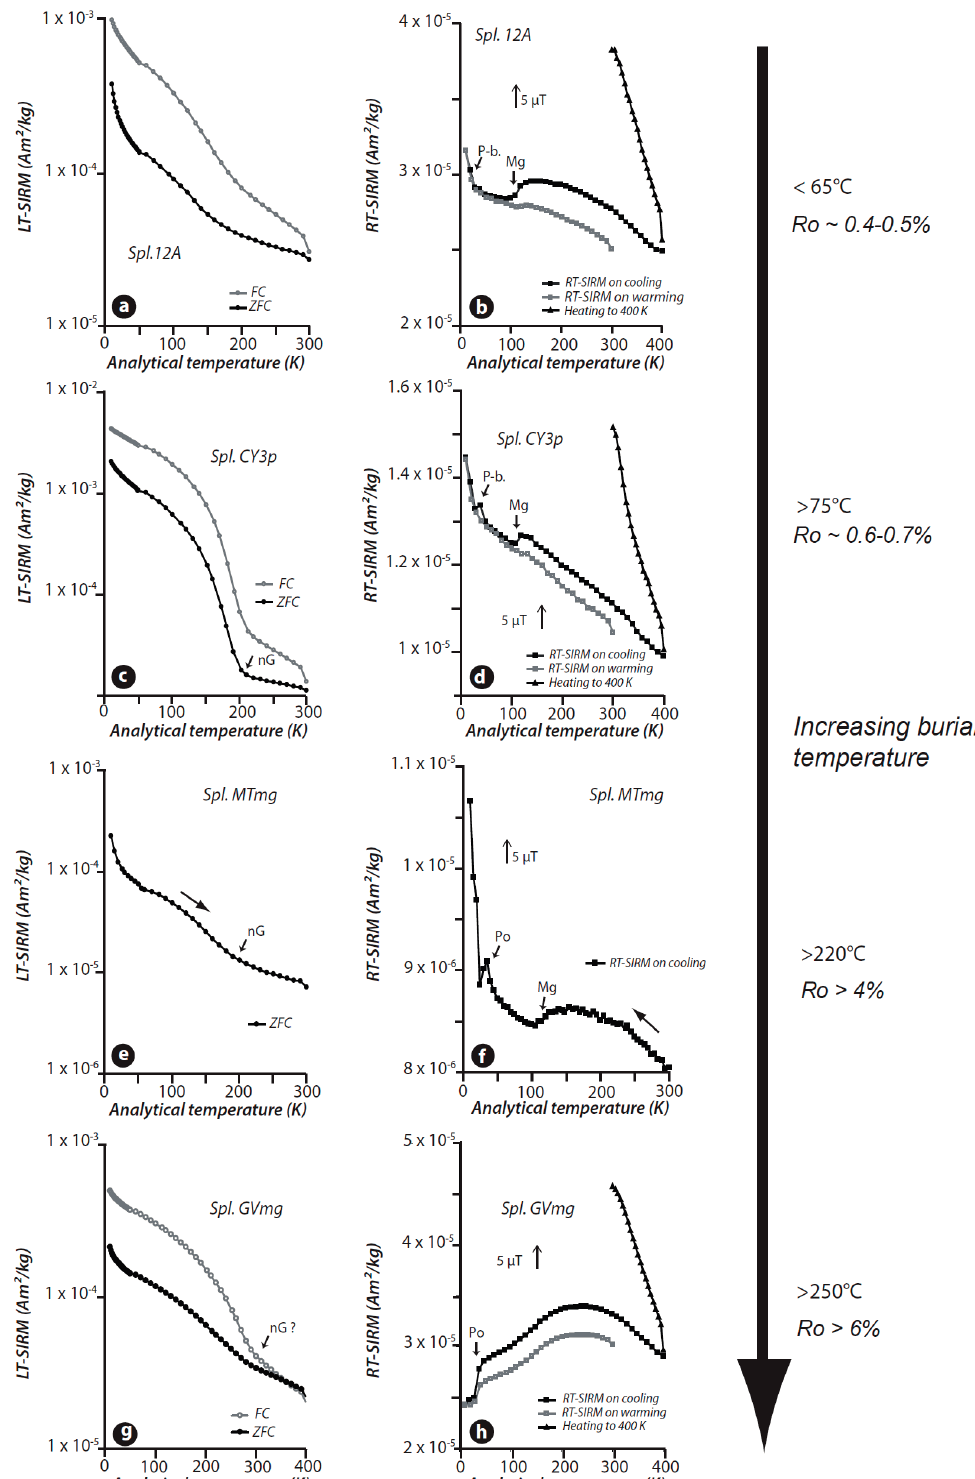
Figure 5. Evolution of the saturation isothermal remanent magnetization for four characteristic samples from the Grès d’Annot basin with increasing